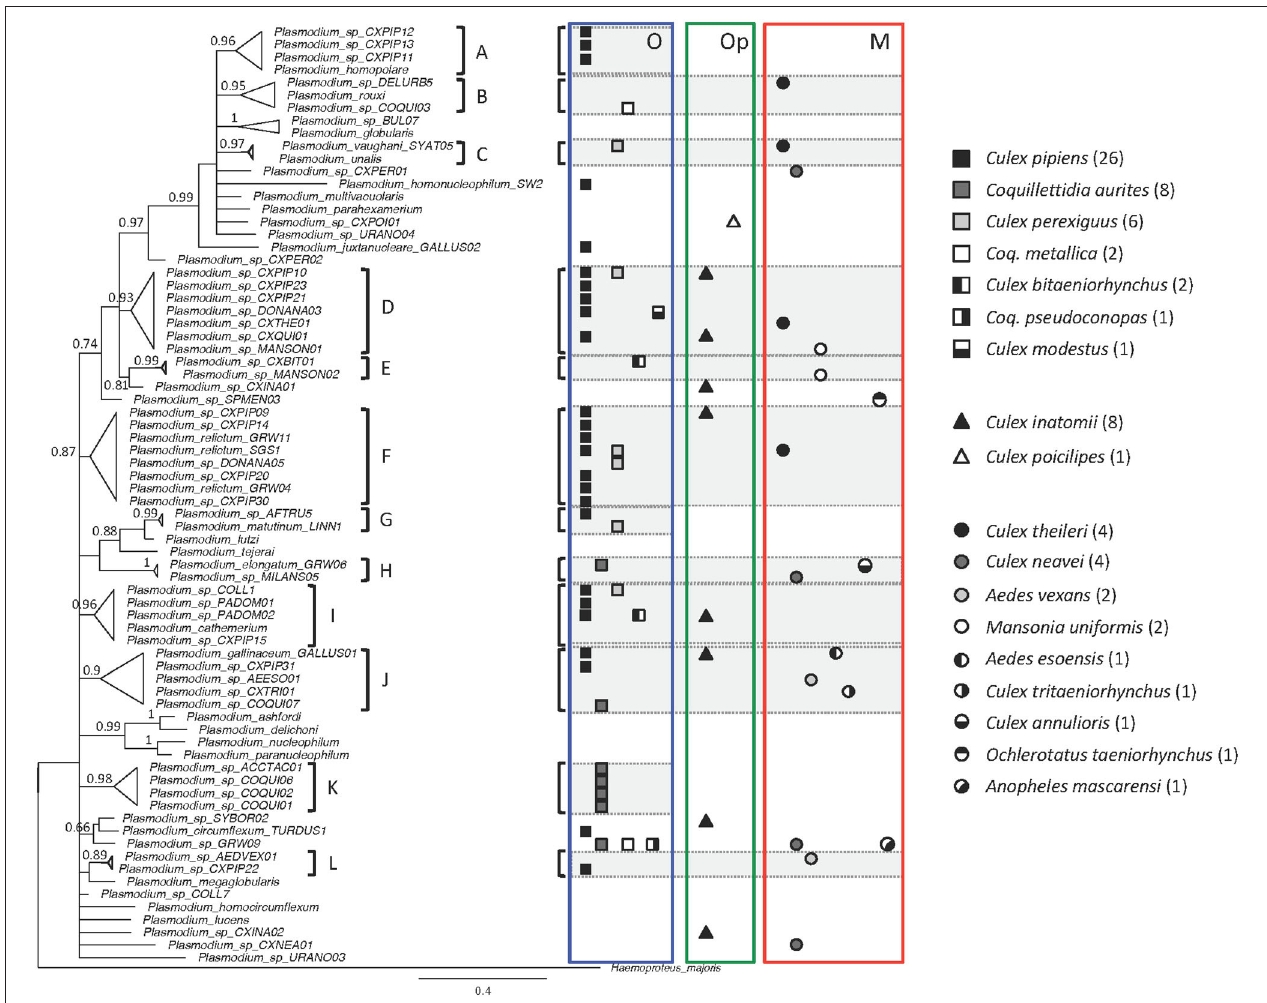
FIGURE 4 | Phylogenetic relationships based on cytochrome b sequences of the 58 Plasmodium lineages found in mosquitoes (head and thorax), as well as 16 morphospecies described in the literature. Morphospecies are shown with their full Latin name while lineages are shown with their MalAvi code (e.g., Plasmodium CXPIP12 ). Numbers located on the top of the branches indicate Bayesian posterior probability values (only values above 0.6 are shown). Twelve clades are represented by a triangular tip with a node support higher than 0.85 and a vertical bar (clades A–L) and correspond to groups of lineages closely related. For each mosquito species, we indicated the feeding preference: ornithophilic (O; square), opportunistic (Op; triangle), mammophilic (M; circle). The four-mosquito species with unknown feeding preferences are not represented in the figure. Haemoproteus majoris was used as the outgroup; scale bar: 0.4 estimated substitutions per site.